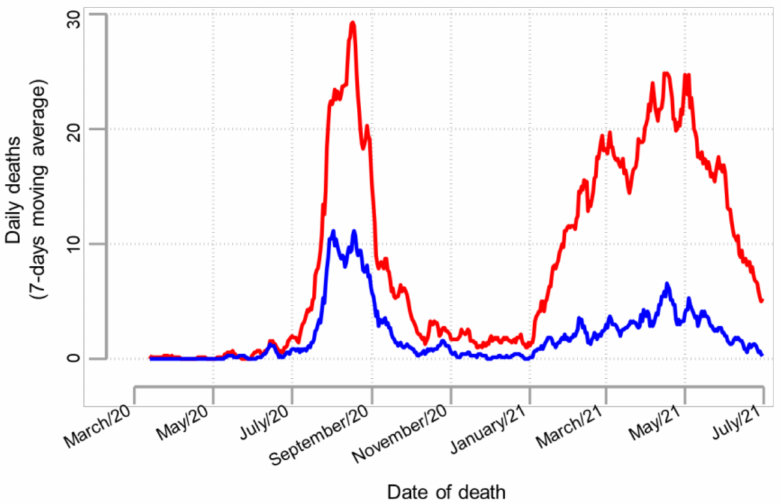
Figure 1. Epidemiological curves by date of death. The curve in red was constructed using the dates of death registered in 2674 records, and the curve in blue using the dates registered in 1225 records. These latter records were randomly selected from the 2674